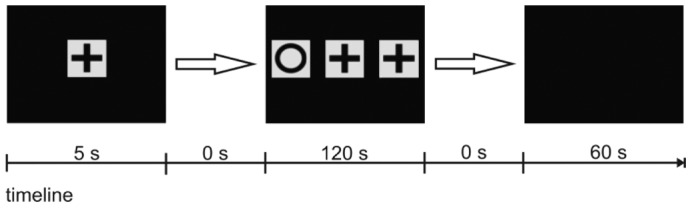
Example of a sequence of PowerPoint slides used in a trial of experiment 1a.The figure shows the chronology of a possible sequence used in a trial of experiment 1a, consisting of three slides presenting the stimuli in a simultaneous MTS. The timeline indicates the duration of each slide's presentation in seconds. The last slide denotes the ITI.